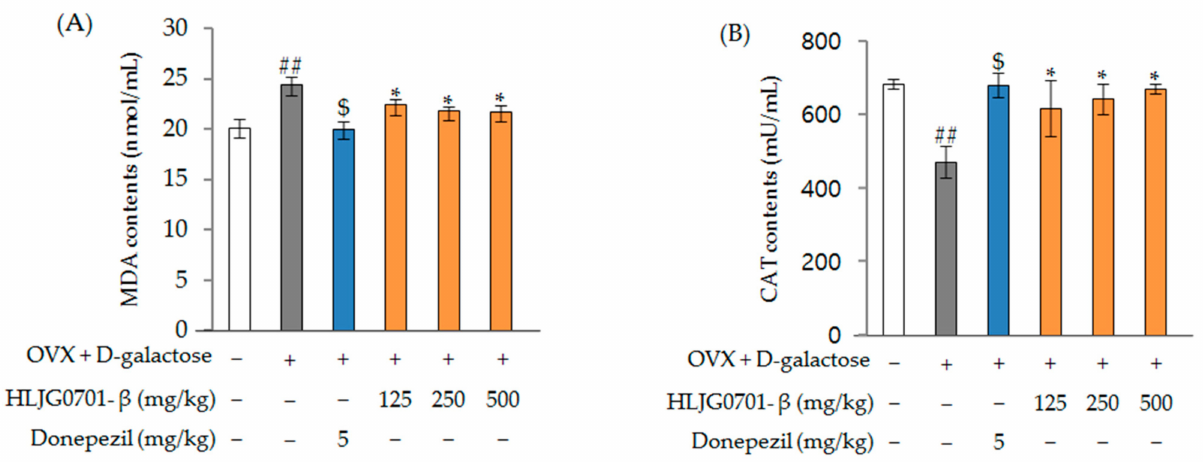
Figure 10. Effect of HLJG0701- β on the contents MDA ( A ) and CAT ( B ) in the blood of mice. Data are presented as mean ± standard deviation. Error bar: standard deviation. ##, significant difference compared with control by Student’s t -test, p < 0.01; $, significant difference compared with OVX + D -galactose group by Student’s t -test, p < 0.05; *, significant difference compared with OVX + D -galactose group by one-way ANOVA, p <